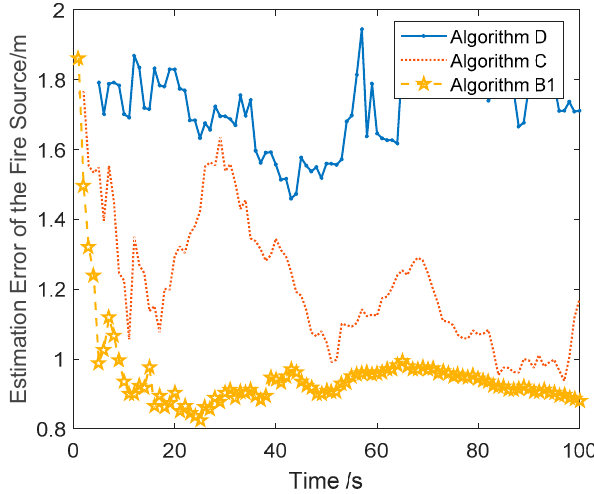
Table 5. Mean estimation error of the fire source by the Algorithms B1, C, and D.